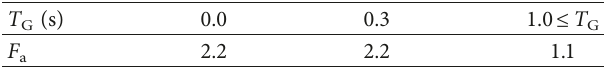
a ; (b) F v . Table 5: Short-period amplification factor according to site period (DRS-2).